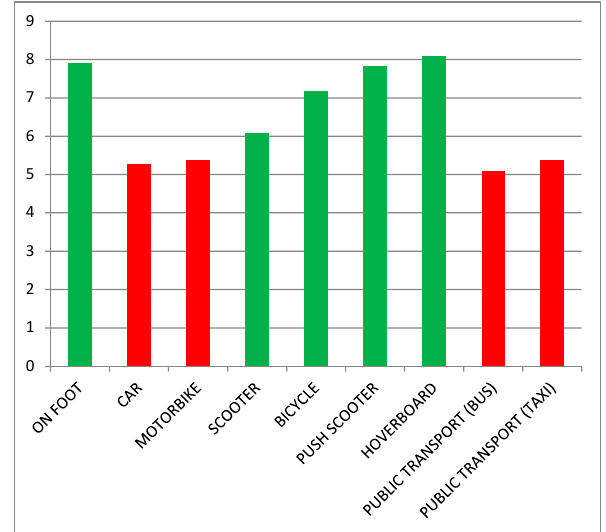
Figure 4. Histogram of analysis of the best innovative renewable energy.